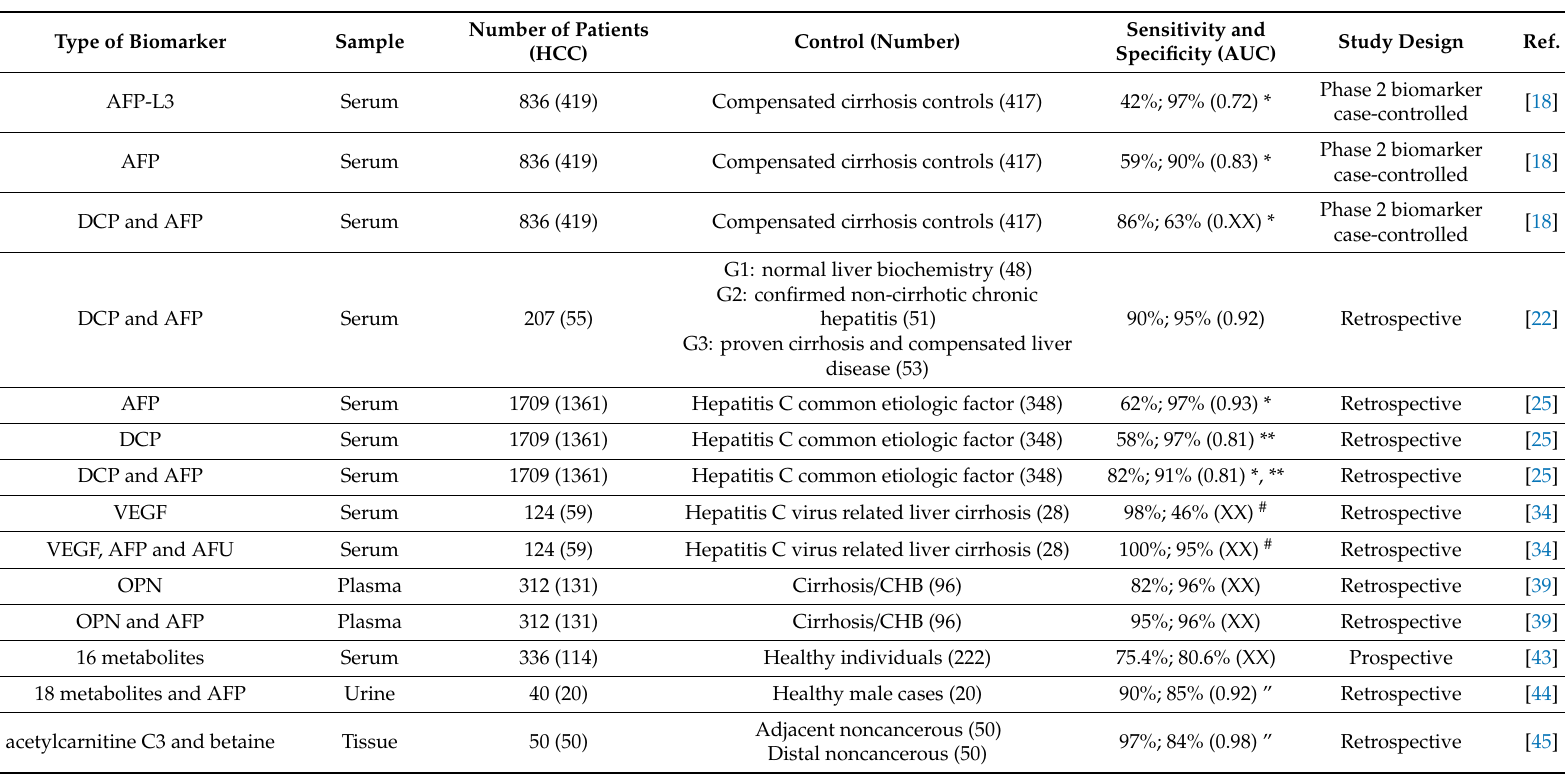
Table 1. HCC: hepatocellular carcinoma, AUC: area under the curve; AFP: alpha-fetoprotein; DCP: Des-gamma-carboxy-prothrombin; * clinical AFP cut-o ff ; ** 40 mAU / mL cut-o ff DCP; CHB: chronic hepatitis B; CTC: circulating tumor cells; EVs: extracellular vesicles; OPN: osteopontin; # depicted ROC provided, but no number given; § pooled sensitivity and pooled specificity; ◦ was not able to di ff erentiate between HCC and CCA; ” values not reported in the studies but estimated from AUC curves; Ref.: